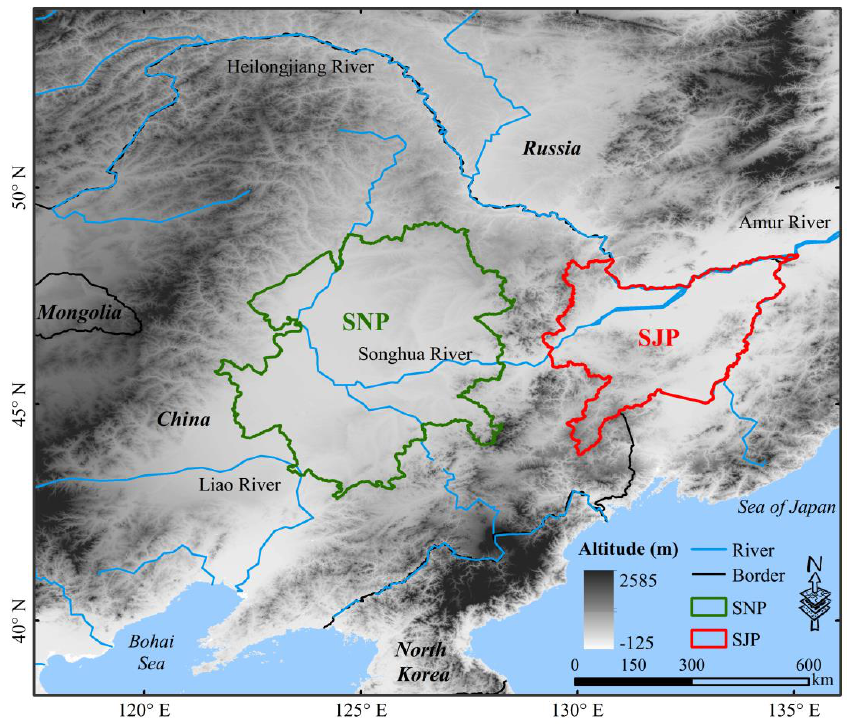
Figure 1. Location map of the SNP and SJP showing digital elevation model (DEM), major rivers and country boundaries.